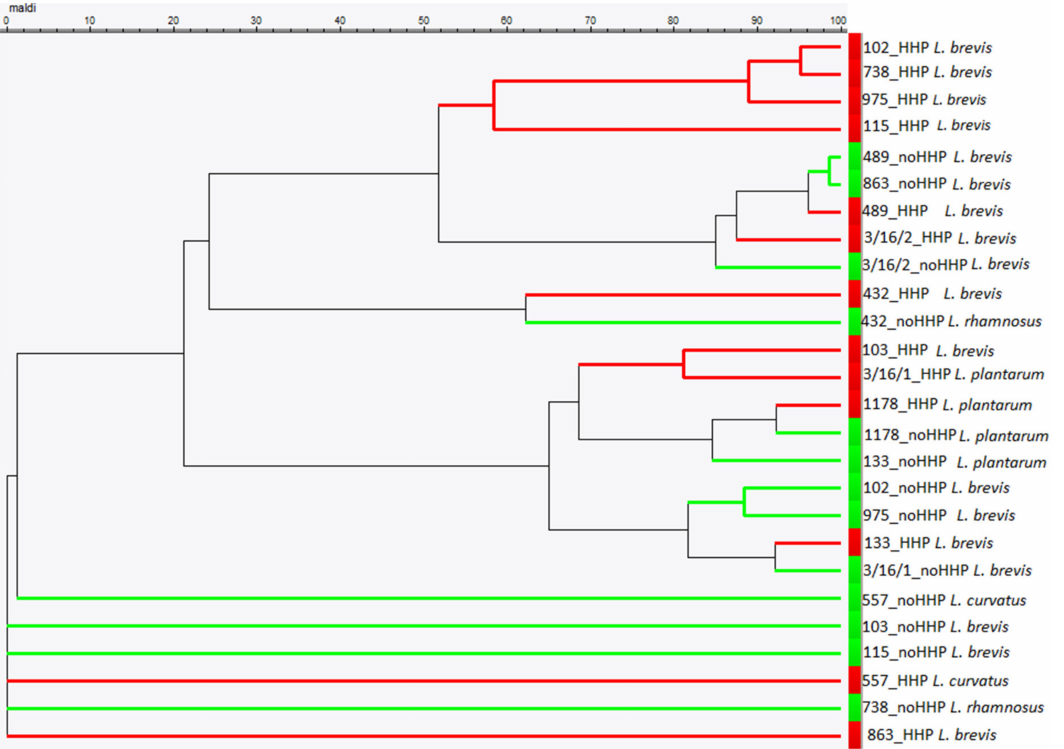
Figure 3. Dendrogram of the composite mass spectra illustrating the hierarchical clustering of the 13 unpressured (green-noHHP) and 13 pressured (red-HHP) strains identified by MALDI-TOF MS (names of strains according to MALDI-TOF MS identification). In the mass spectrum profile (MSP) dendrogram, the relative distance between the strains is displayed as arbitrary units, where 100 indicates complete similarity and 0 indicates maximum